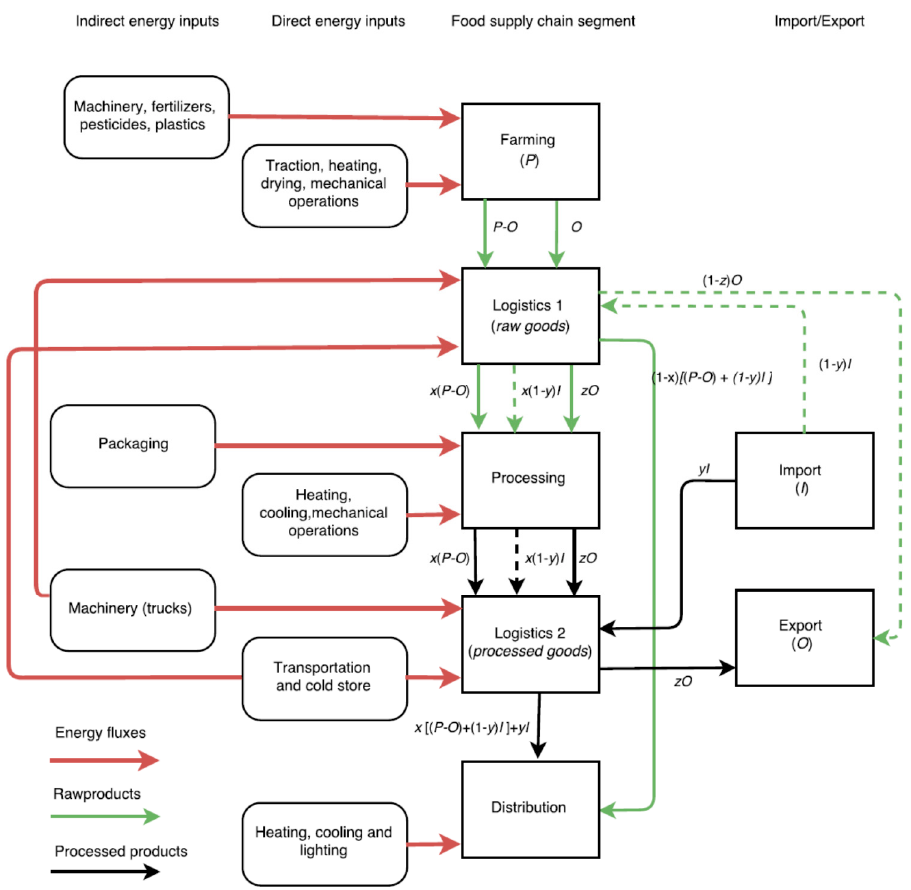
Figure 1. Flow chart of Italian FSC with direct and indirect energy inputs and raw and processed biomass fluxes; x , y and z are the fractions of processed food in national production, import and export, respectively (see Section 2.2). Products for animal feed are not indicated.